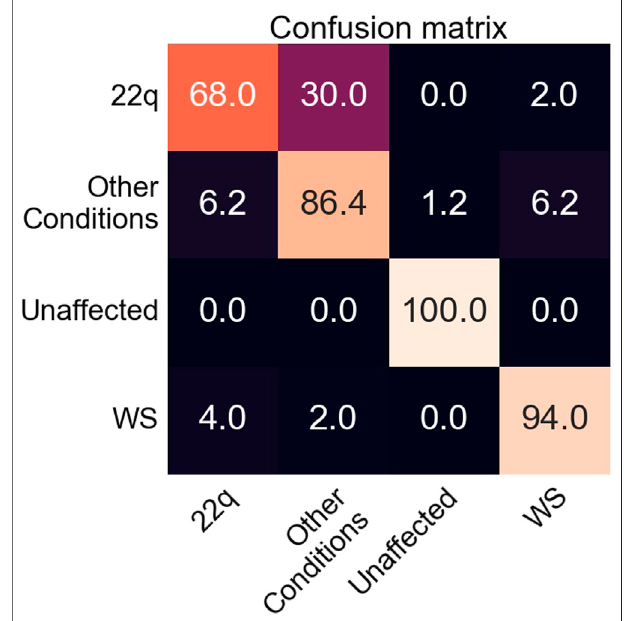
FIGURE 3 | Confusion matrix of accuracy of the classi fi er trained on real images. Rows represent the correct label, while columns represent the label chosen by the classi fi er. The diagonal numbers represent the percent accuracy for each category (the percentage of images when the correct label was identi fi ed), while the off-diagonal numbers represent misclassi fi cation percentage ascribed to an incorrect category. Accuracy is based on 50 test images of WS, 50 of 22q, and 81 of other